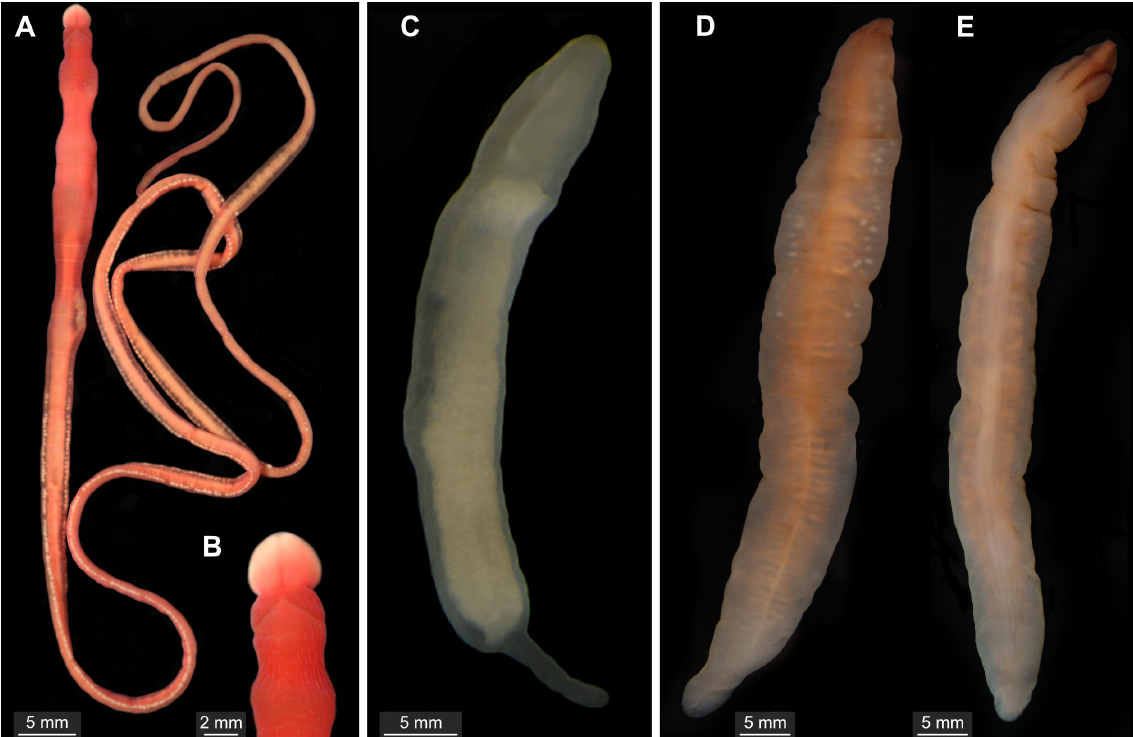
Fig. 3. Live images of palaeonemerteans, heteronemerteans, and polystiliferous hoplonemerteans collected along the Costa Rica margin. A . Tubulanus cf. lutescens (SIO-BIC N107) (Palaeonemertea). B . Dorsal surface of head region of Tubulanus cf. lutescens (SIO-BIC N233). C . Lineidae (SIO-BIC N254) (Heteronemertea). D–E . Reptantia (SIO-BIC N263) (Polystilifera) dorsal (D) and ventral view